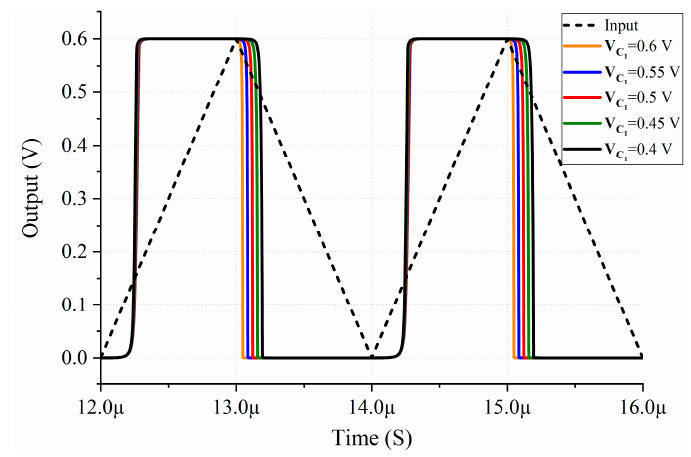
Figure 10. Variation of the time-domain response of the proposed circuit by changes of Vc 1 .